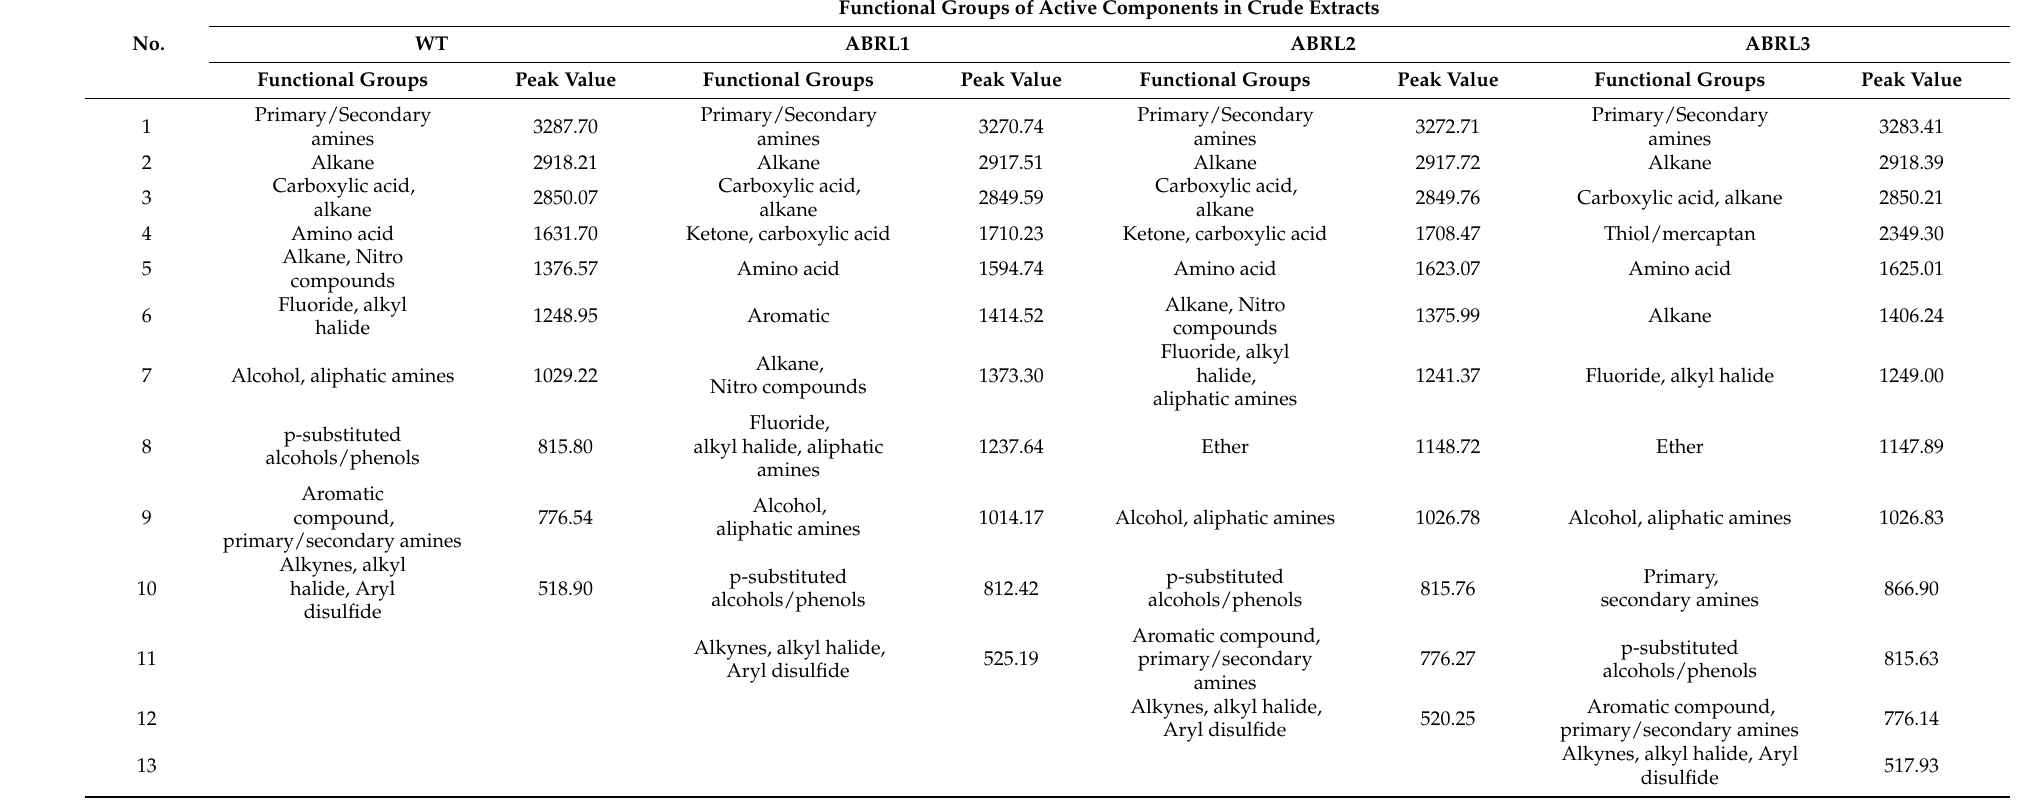
Table 1. FTIR analysis and functional